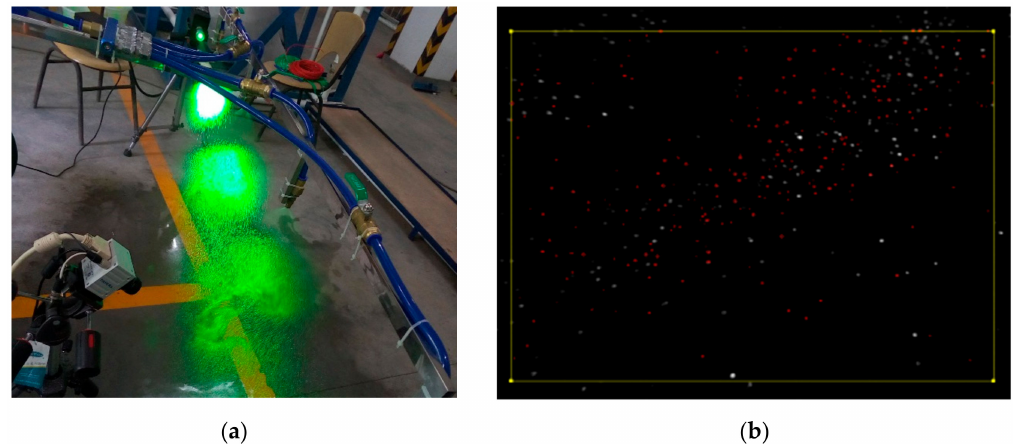
Figure 9. Doppler particle sensor experiment. ( a ) Doppler particle sensor measuring droplet size; ( b ) Doppler particle sensor capturing particle